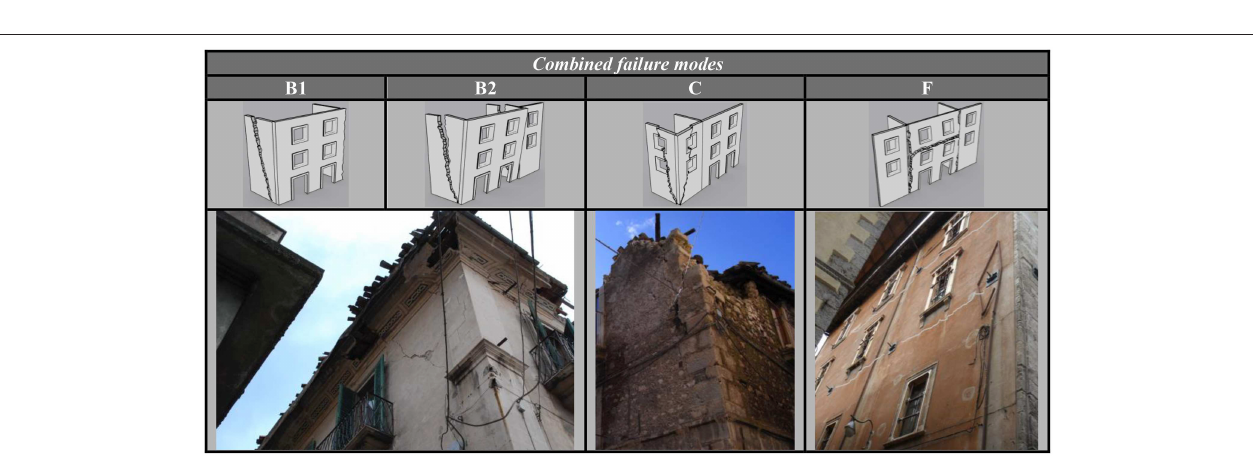
Frontiers in Built Environment |